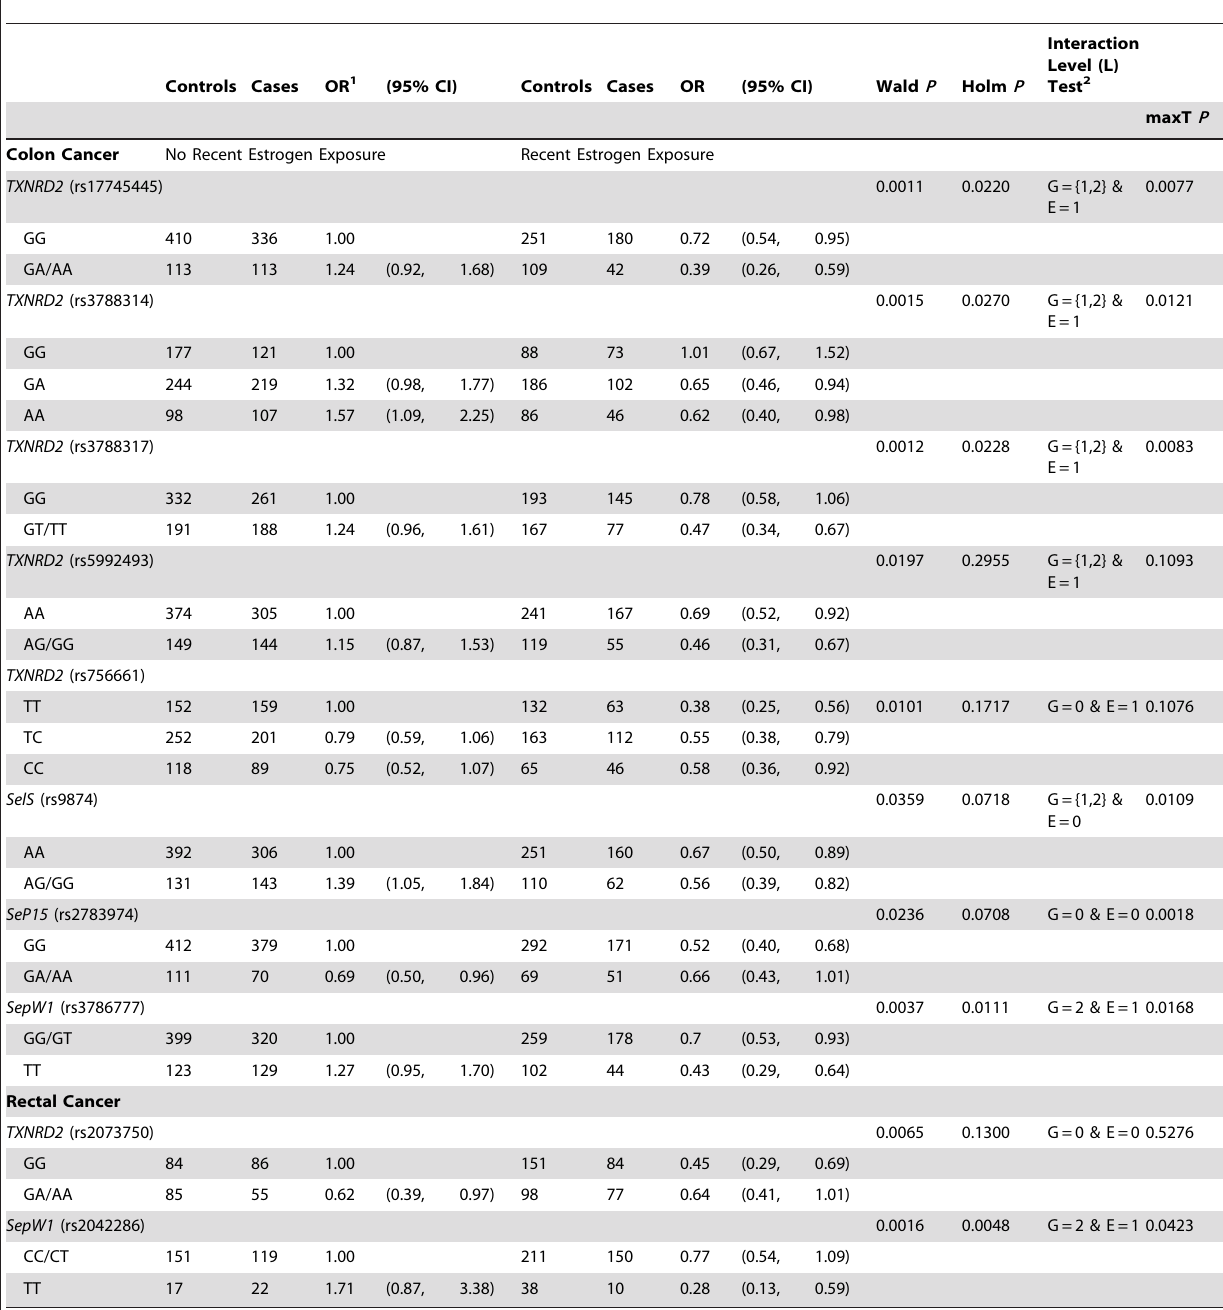
Table 4. Associations between TXNRD and selenoprotein SNPs and estrogen and risk of colon and rectal cancer.